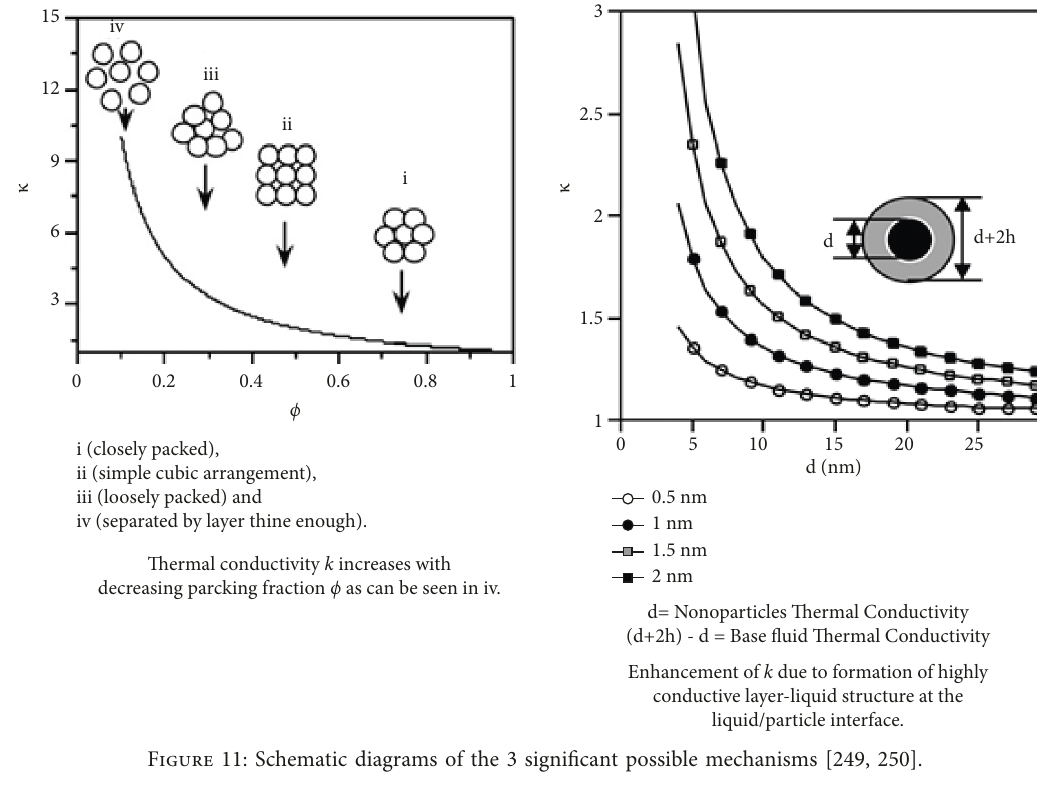
Figure 11: Schematic diagrams of the 3 significant possible mechanisms [249,